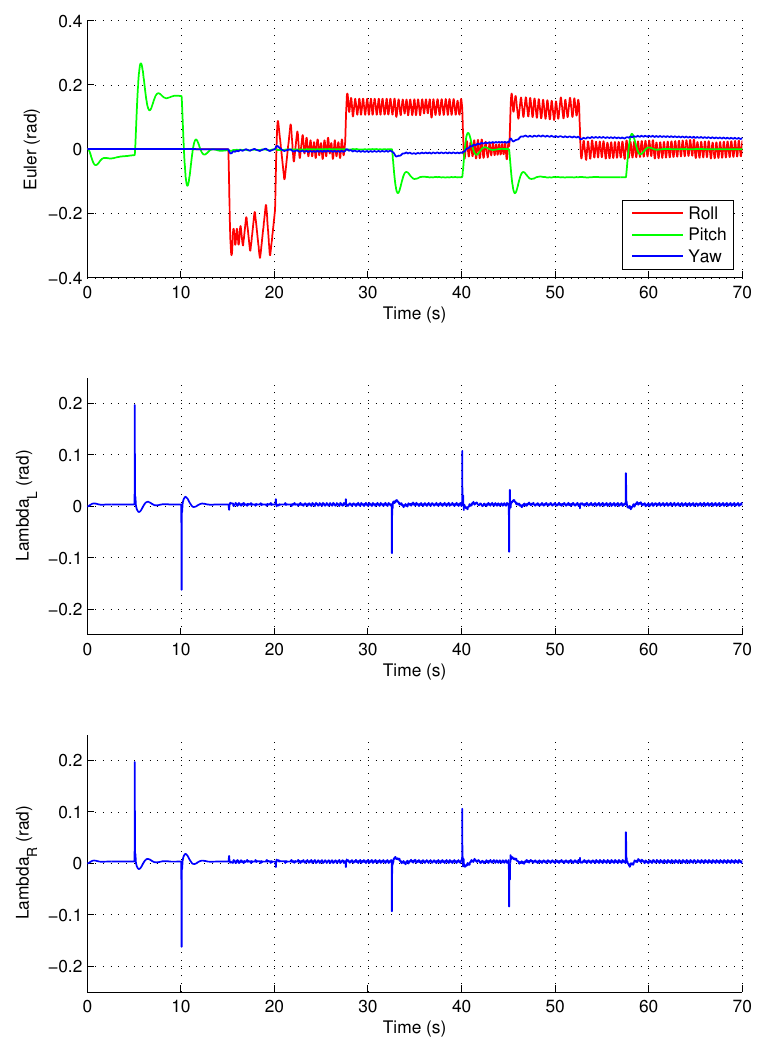
Figure 10. Rotor deflection against modifications in φ and θ